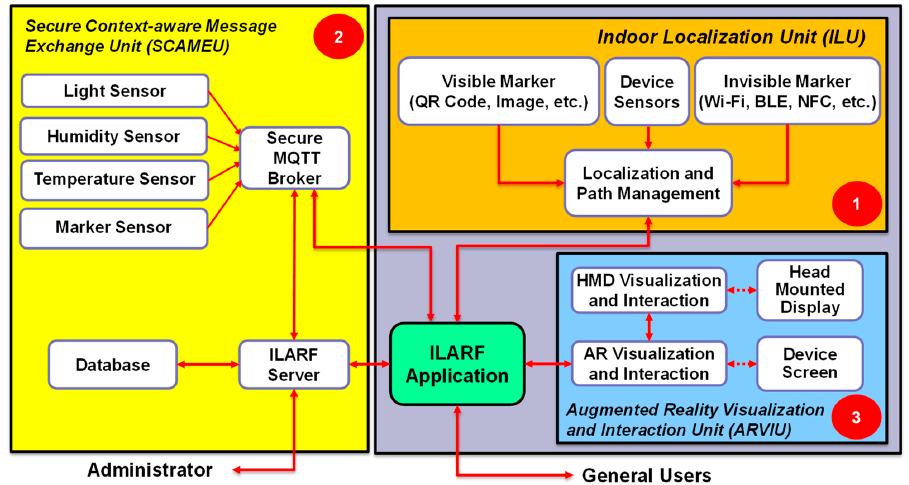
Figure 1. Diagram of ILARF architecture.